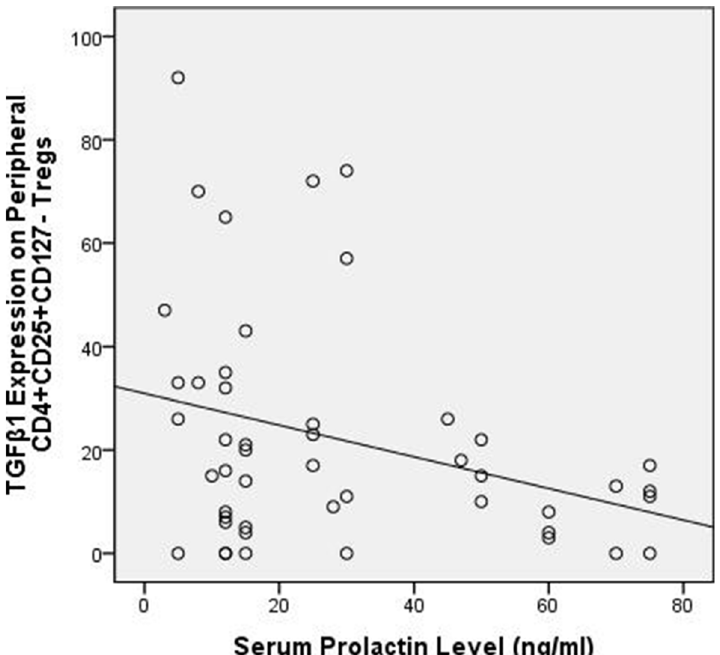
Fig. 3 The correlation between the frequency of mTGF‑ß1on CD4